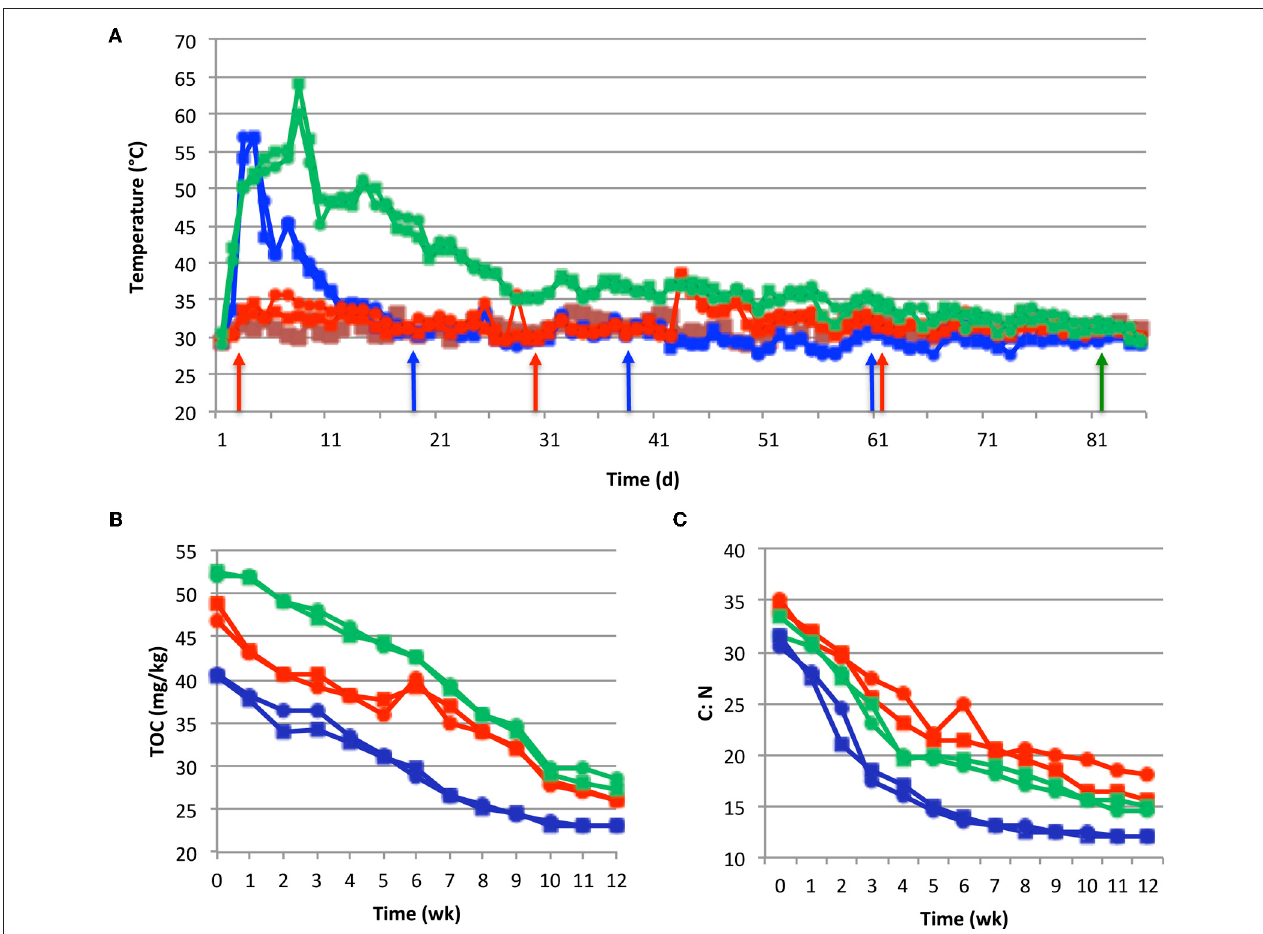
FIGURE 1 | Compost physico-chemical dynamics. Panel A , temperature; Panel B , total organic carbon (TOC); Panel C , C:N. All plots are coded as: blue, rice; red, bagasse; green, coffee; squares, cow manure; circles = sheep manure. In Panel A , ambient temperature is plotted as a brown line, and arrows indicate approximate times of peaks in nitrification